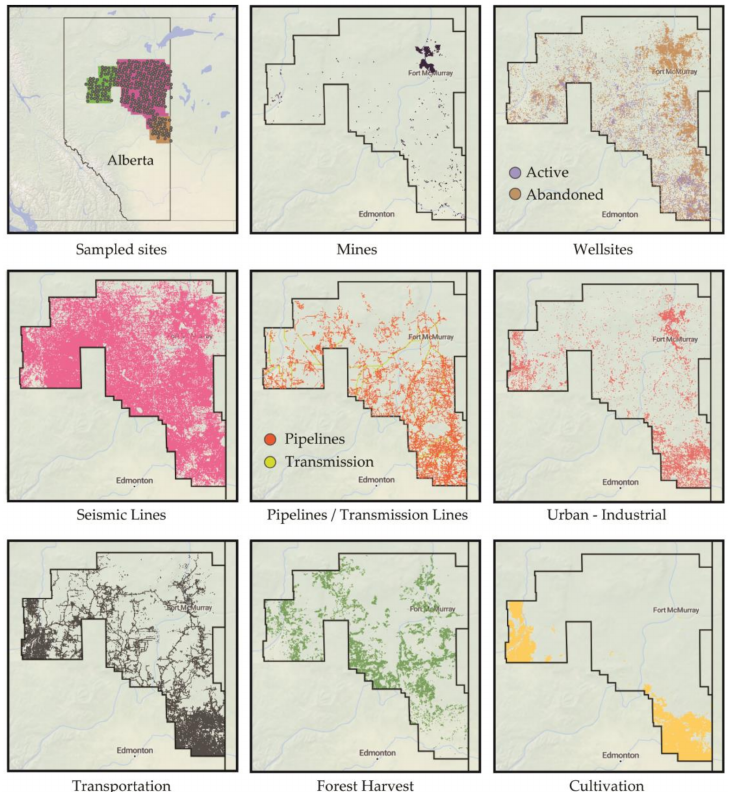
Figure 1. ( Top left ) is a map of Alberta, Canada showing oribatid mite collection localities within the oil sands region (Athabasca Oil Sand Area in pink, Cold Lake Oil Sand Area in orange, Peace River Oil Sand Area in green), and the remaining maps are of the main human footprint types in the oil sands region in 2018 (available on the ABMI mapping portal at https://maps.abmi.ca (accessed on 8 March